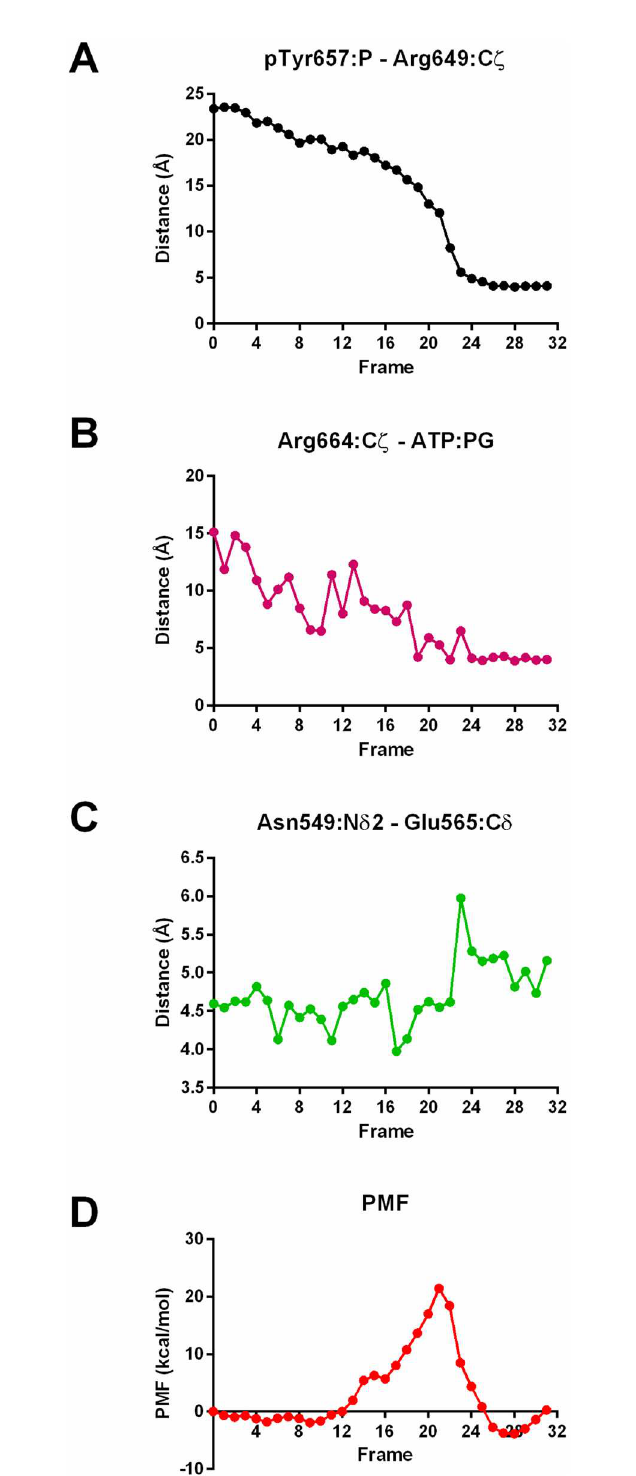
Fig 2. Key distances and potential of mean force along minimum free energy path. (A, B, C) Distances betweenkey atoms over the course of the string method pathway. (D) Potential of mean force as a function of collectivevariables used in the string method